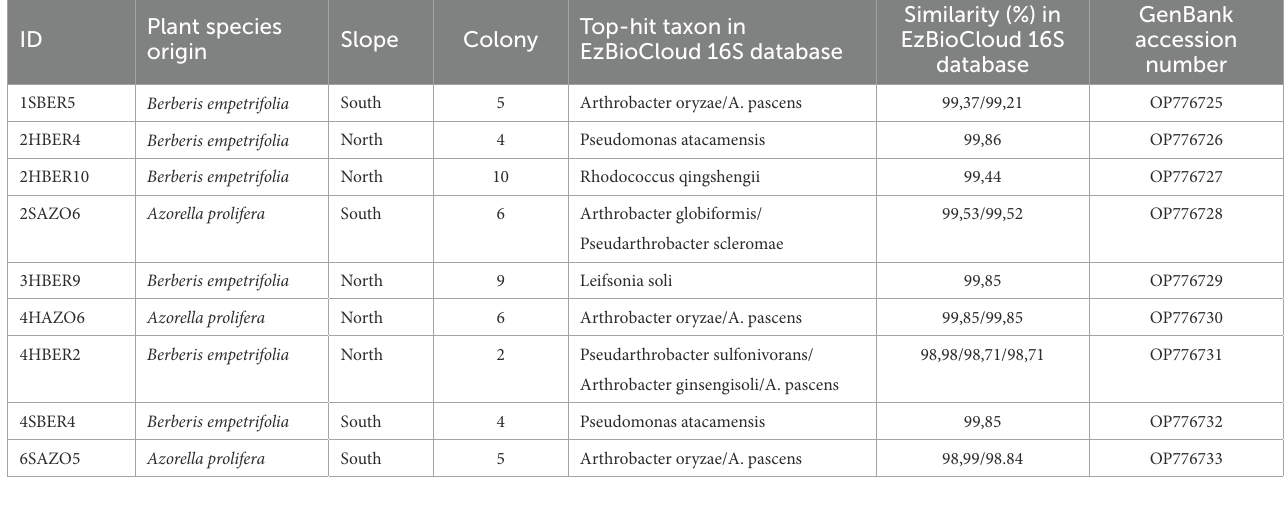
TABLE 3 Bacterial sequences obtained for 9 of the most abundant colonies isolated from soil under plant xerophytics species in the Nevados de Chillán Volcano Complex. See Materials and Methods for details.